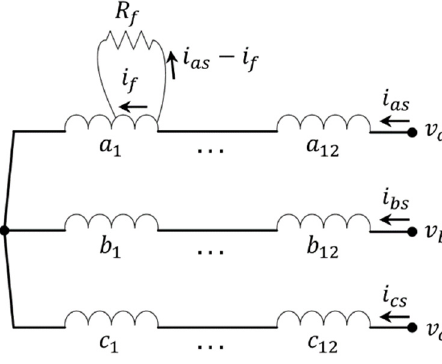
Figure 1. 4-pole 36-slot Induction motor series connected winding configuration with an ITF.